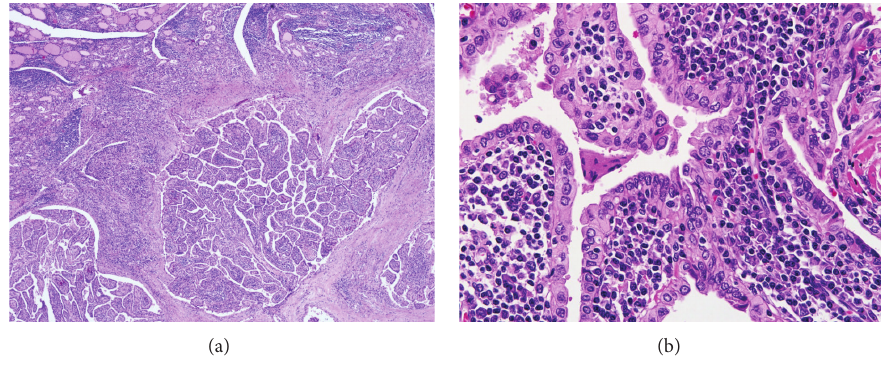
Figure 1: The Warthin-like variant of papillary carcinoma is associated with chronic lymphocytic (Hashimoto) thyroiditis. (a) The tumor shows well-developed papillae with dense lymphoplasmacytic infiltration of the stalks. The surrounding normal thyroid parenchyma exhibits Hashimoto’s thyroiditis. (b) Tumor cells have granular oncocytic cytoplasm and nuclear features of papillary carcinoma including optically clear nuclei, nuclear grooves, and intranuclear pseudo-inclusions. A dense infiltration of lymphoplasma cells is seen in the stalk of papillary